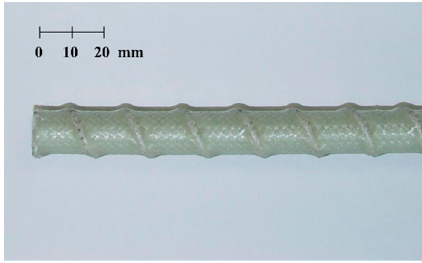
Figure 3. Shape of the Korea Institute of Civil engineering and Building Technology-(KICT) developed GFRP rebar.